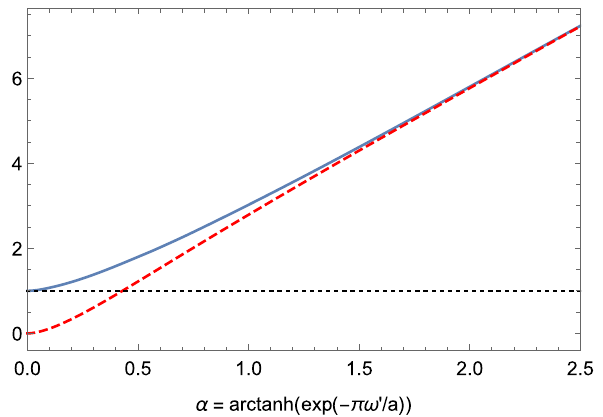
Fig. 3 Mutualinformation–Thestate ρ M , I isthebluesolidline, ρ M , II is the red dashed line and ρ I , II is the black dotted